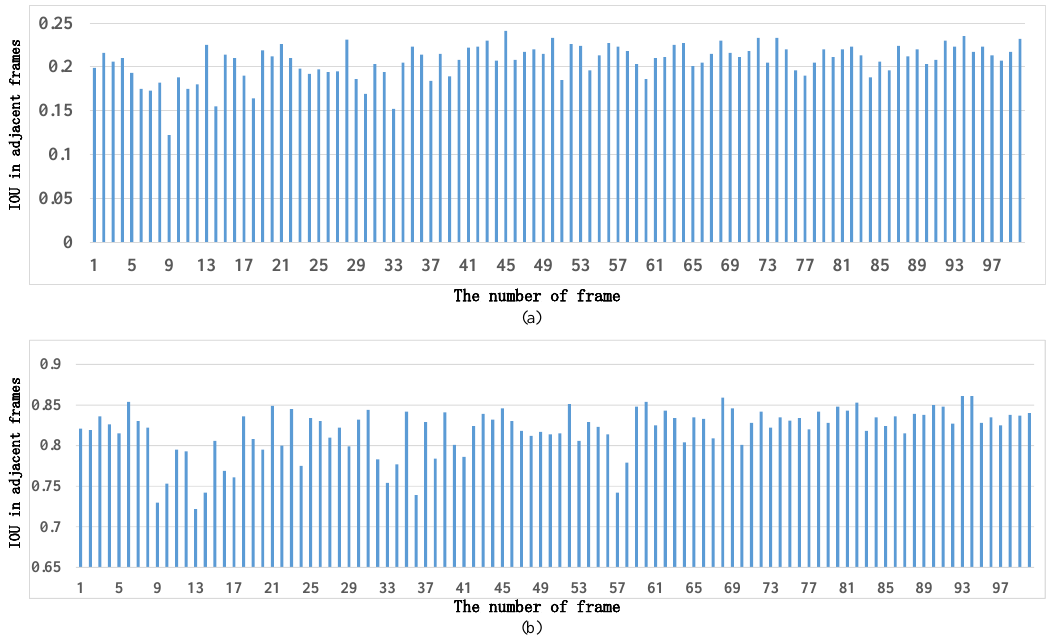
Figure 11. The IOU in adjacent frames: ( a ) the result of the CBAF module is only approximately 0.2; ( b ) the result of the ODEM-GAN module is increased to approximately 0.78, and the jitter is effectively suppressed.